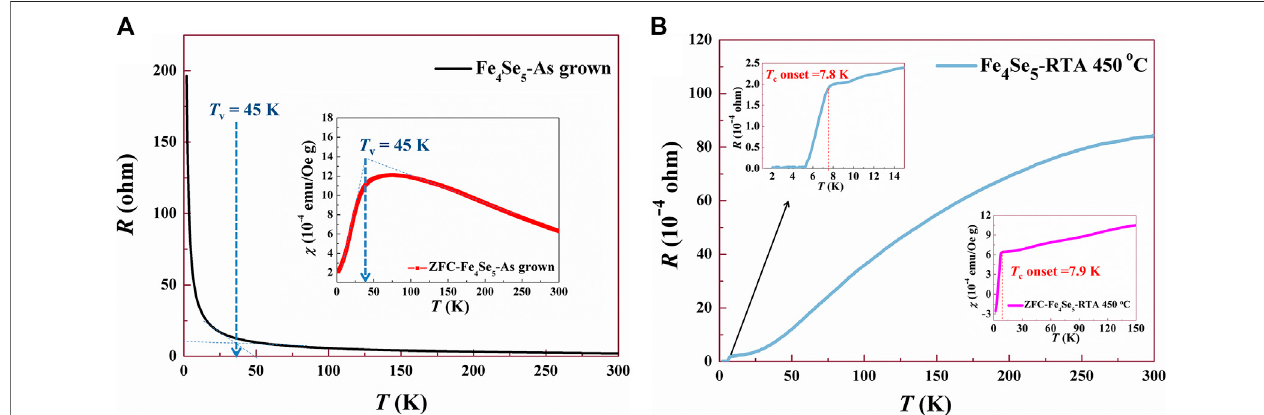
FIGURE 2 | (A) Temperature-dependent resistance of the as-grown Fe 4 Se 5 sample showing a metal-insulator transition T V with the onset of resistance rise at ∼ 45 K. The inset is the magnetic susceptibility from 300 to 2 K of the same sample, which shows a large drop in susceptibility with the onset temperature also at ∼ 45 K. (B) Temperature-dependent resistance of the Fe 4 Se 5 sample after 450 ° C RTA process. The sample becomes metallic and shows superconducting transition with the onset